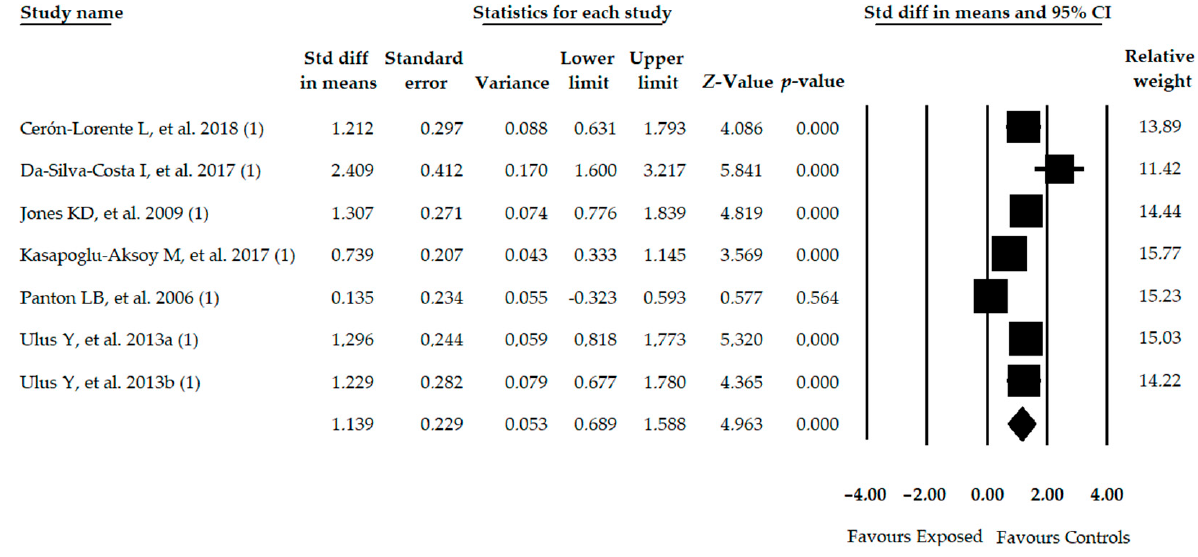
Figure 2. Forest plot of the meta-analysis of functional balance . Std diff, Standardized difference; CI, Confidence interval.